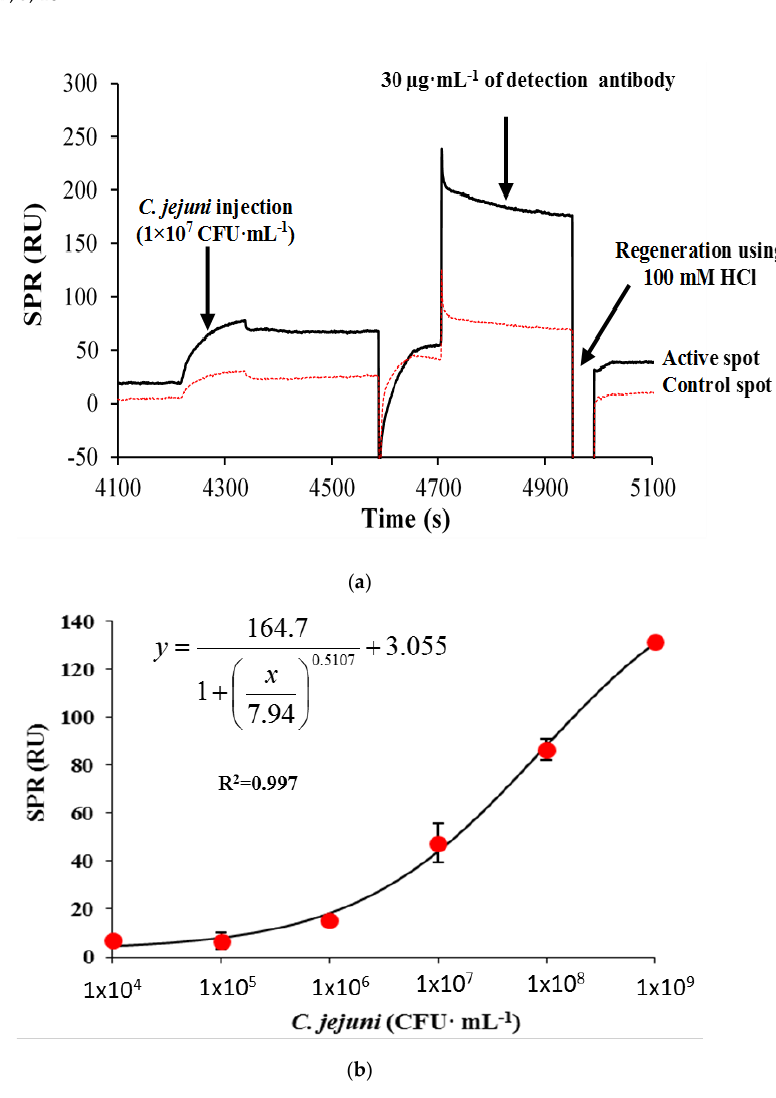
Figure 3. The surface plasmon resonance (SPR) sensorgram showing the binding response of 1 × 10 7 CFU mL −1 C. jejuni on the target (black line) and control surfaces (red line) followed by an injection of the detector antibody in a sandwich assay format ( a ), and the corresponding C. jejuni standard curve ranging from 1 × 10 4 to 1 × 10 9 CFU·mL −1 . Bars represent mean ± standard deviation of triplicates ( b ). (The same concentration (70 µg·mL −1 ) of the surface antibody was used for the immobilization of target ( C. jejuni specific antibody) and control (mouse IgG antibody) antibodies).